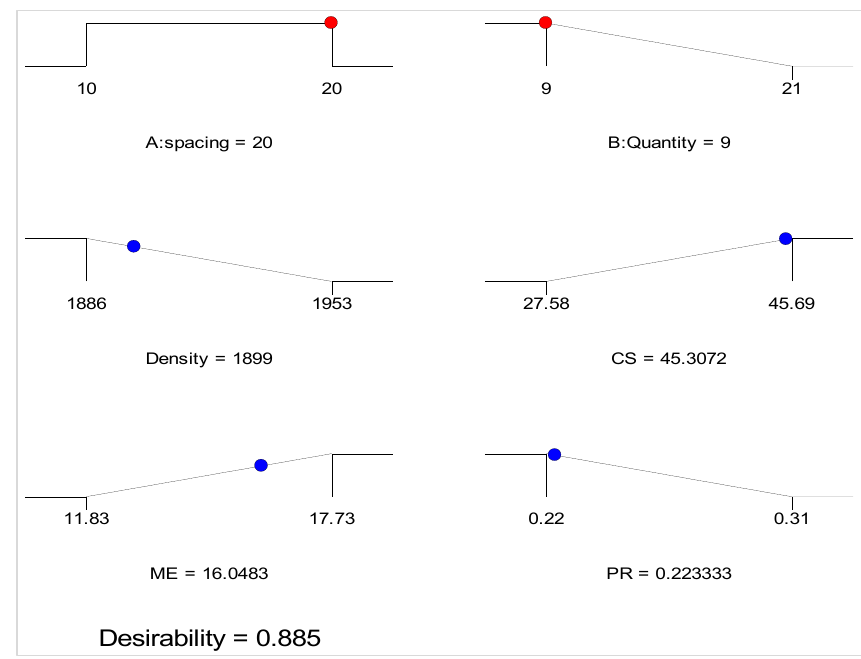
Figure 19. Optimization solution ramps.